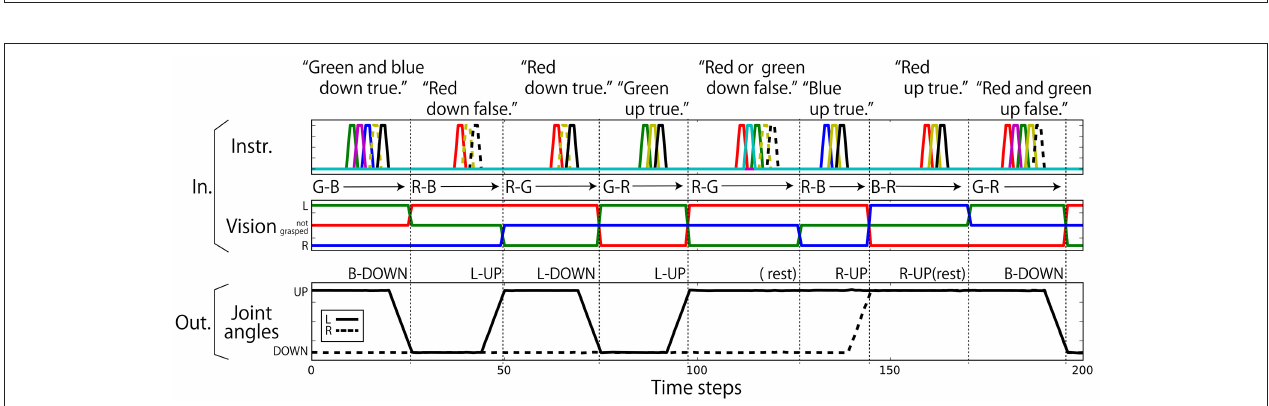
FIGURE 5 | An example of the resulting interaction in the flag task. The 300-node model could generate an appropriate action in almost all situations.